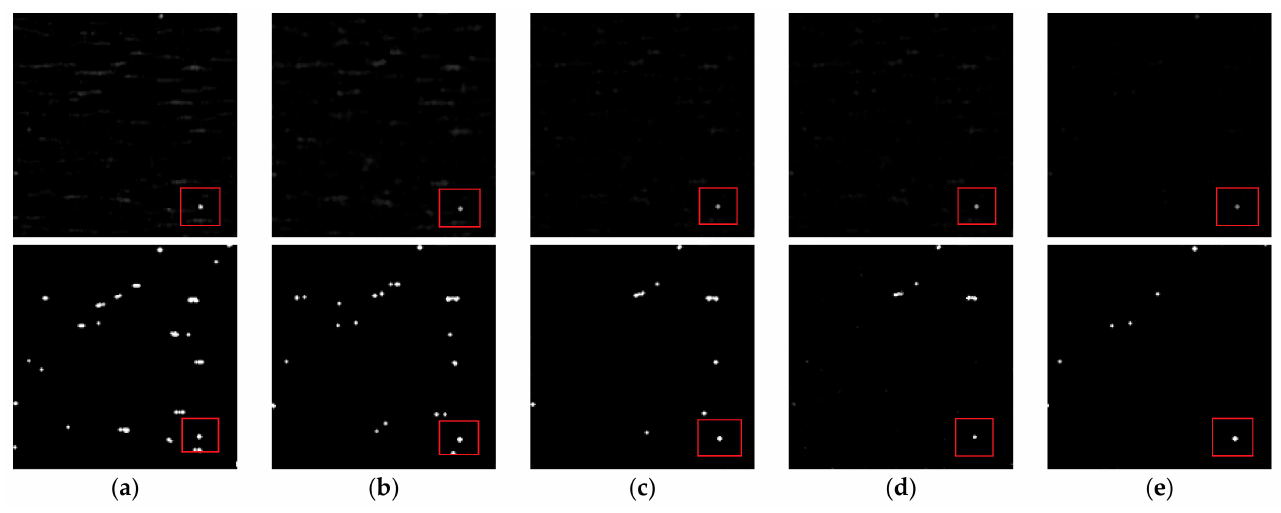
Figure 14. Moderately undulating sea clutter. ( a ) Top-hat. ( b ) Spatial dynamics. ( c ) Temporal dynamics. ( d ) Spatio-temporal filter. ( e ) Proposed